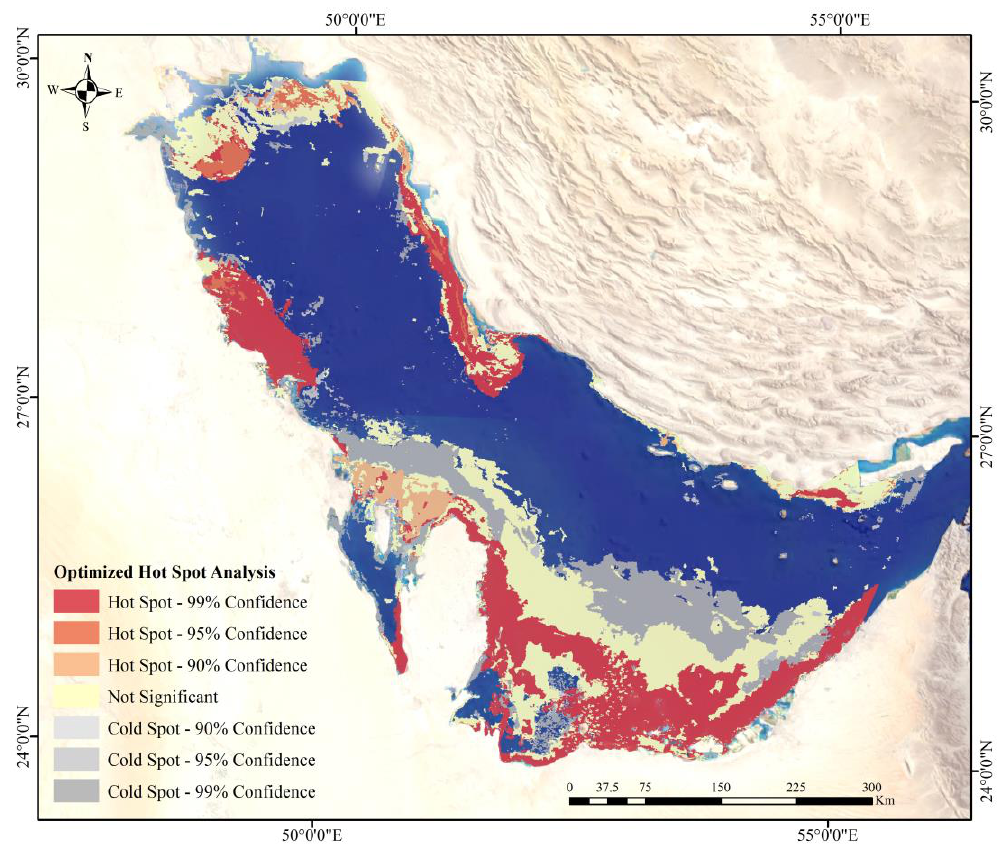
Figure 9. High spatial frequency of whiting events overs 17 years.